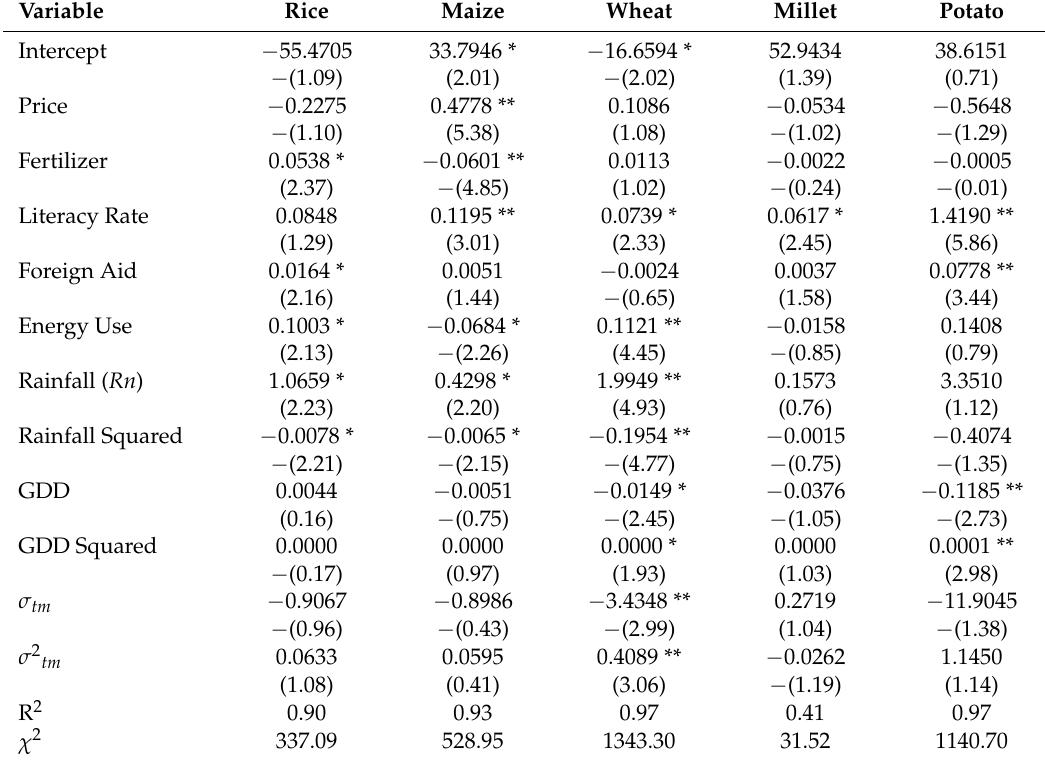
Table 2. Seemingly Unrelated Regression (SUR) Parameters for Crop Yield